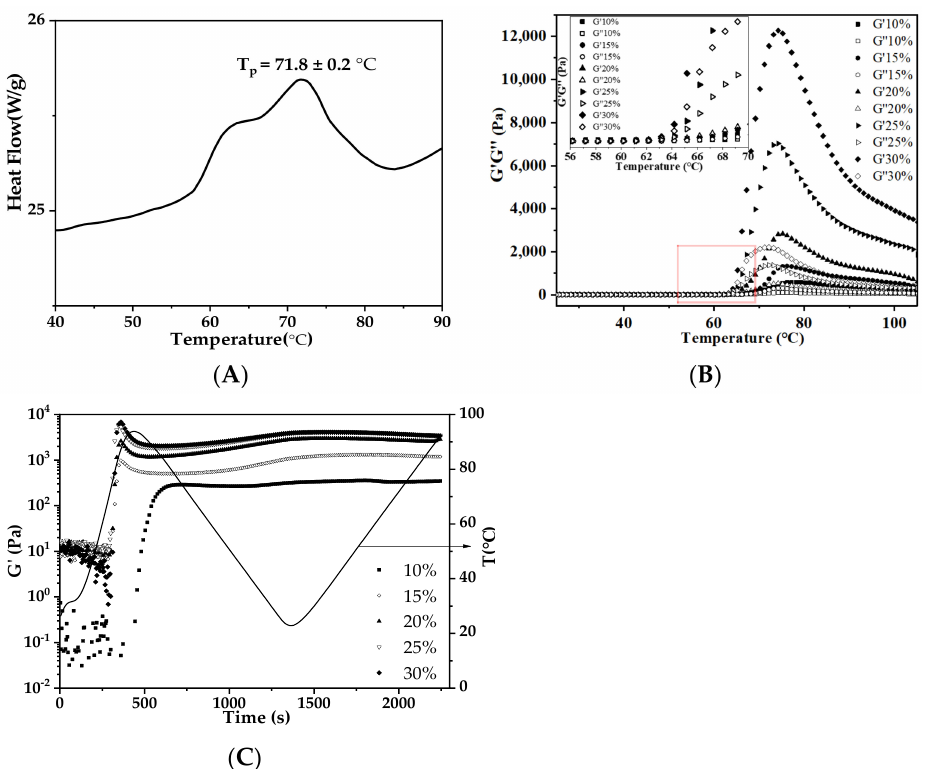
Figure 4. ( A ) Differential scanning calorimetry thermogram of arrowroot starch; ( B ) plots of storage modulus (G ′ ) and loss modulus (G ′′ ) versus temperature for arrowroot starch samples with concentrations ranging from 10% to 30%; and ( C ) effect of variable temperature scanning (heating → cooling → heating cycle) on storage moduli of arrowroot starch samples with concentrations ranging from 10% to 30%.